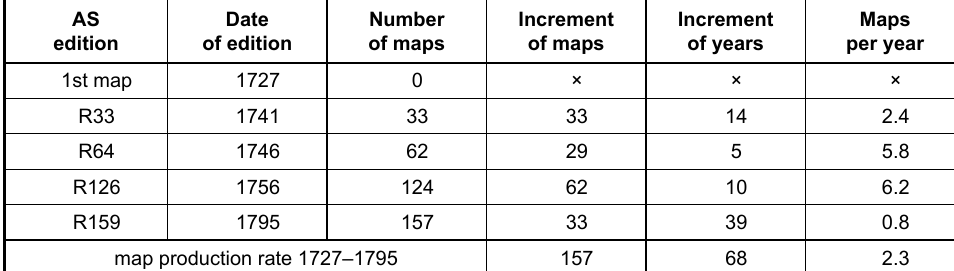
Table 3. Atlas selectus − map production